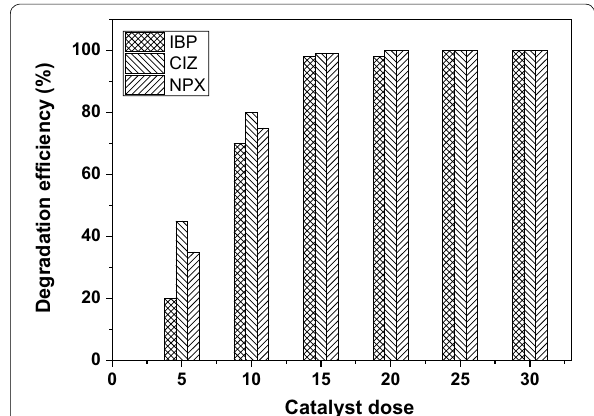
Fig. 1 Effect of photocatalyst amount on the photodegradation efficiency of IBP, NPX, and CTZ under UV-light irradiation using PAN-MWCNT/TiO 2 –NH 2 composites nanofibers. The drug solution 5 mg/L, pH 2, and total volume of 100 mL, irradiation = = time (IBP 120 min, NPX 40 min, CIZ 25 min) = = =